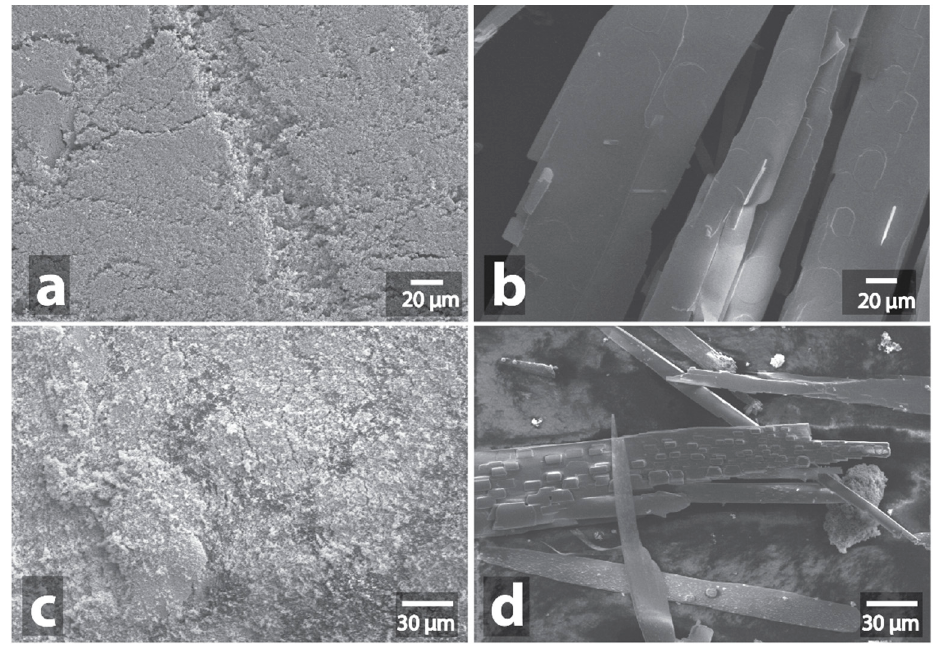
Figure 7. SEM image of initial Mo/C powder ( a ) and SEM image of Mo/C powder after MW-treatment ( b ), initial MoS 2 powder ( c ) and SEM image of MoS 2 powder after MW-treatment ( d